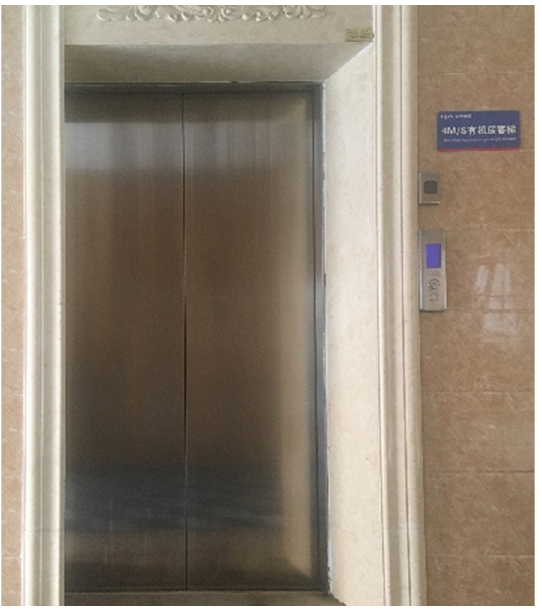
Fig. 4. The high-speed elevator test tower. Fig. 5. 4m/s high-speed elevator.